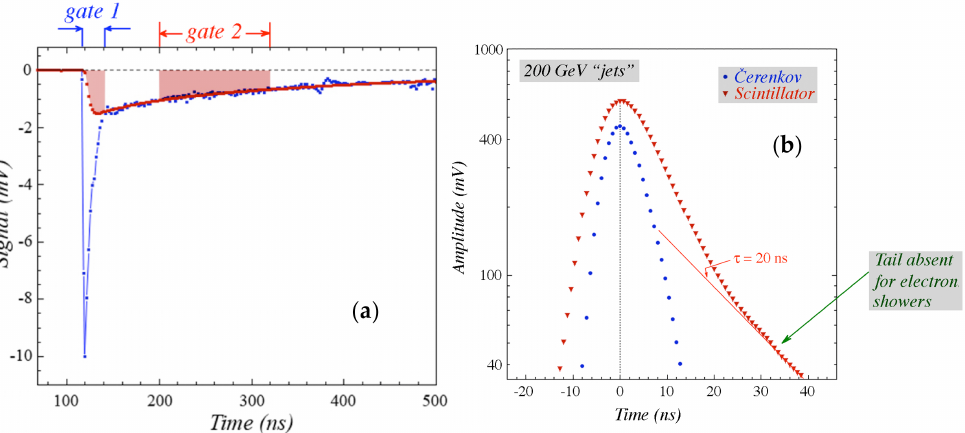
Figure 10. RD52 results on tests of the DREAM calorimeter preceded by a BGO em section. See text for